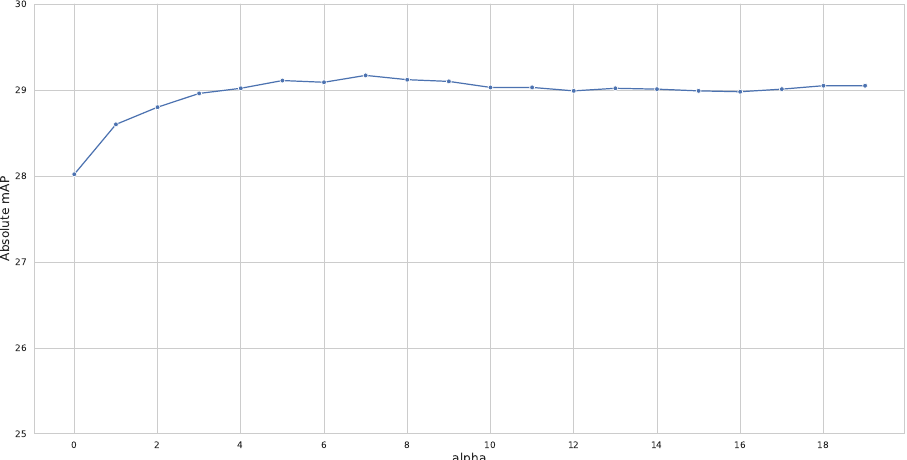
Figure 10. Evolution of the absolute mAP against α with the MD